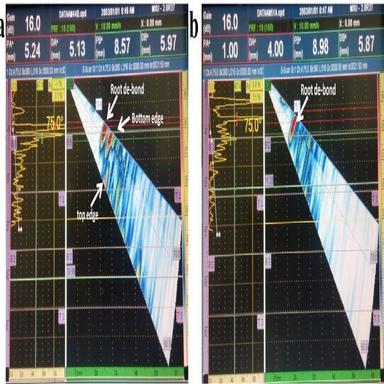
PAUT image showing root de-bonding defects.